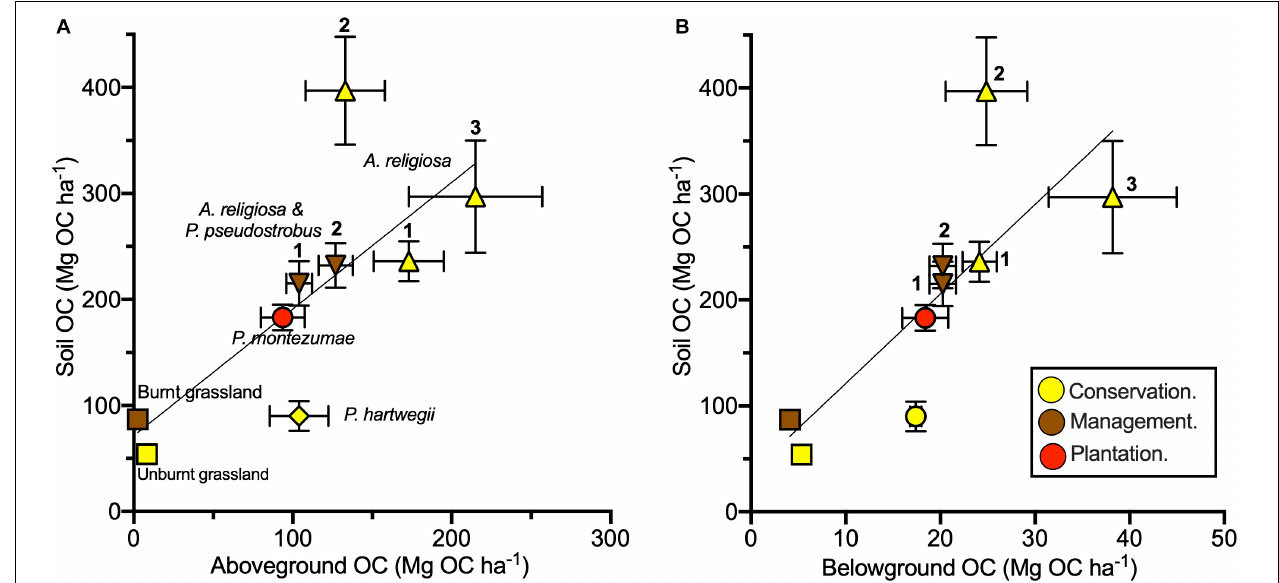
FIGURE 3 | (A) Relationship between soil OC (Mg OC ha − 1 ) and aboveground OC (Mg OC ha − 1 ) at nine habitats within the Nevado de Toluca Conservation Area. The regression line was y = 1.2 x + 71.5, R 2 = 0.6, p = 0.02. (B) Relationship between soil OC (Mg OC ha − 1 ) and belowground OC (Mg OC ha − 1 ) at nine habitats within the Nevado de Toluca Conservation Area. The regression line was y = 8.5 x + 36.6, R 2 = 0.62, p = 0.01.